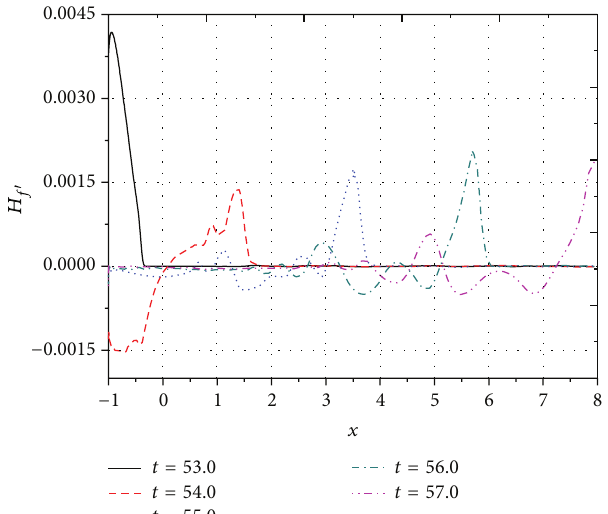
Figure 6: Distribution of wall heat flux disturbance 𝐻 󸀠 𝑓 (𝑥,𝑦,𝑡) at different